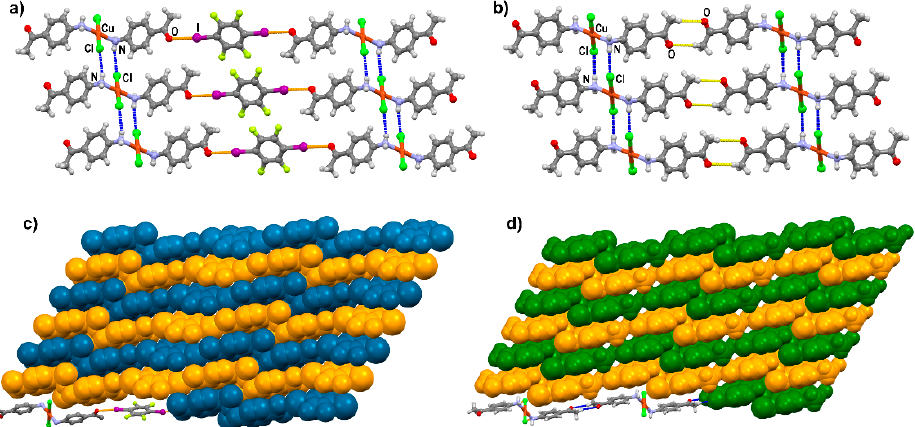
Figure 4. Parts of the crystal structure of ( a ) [CuCl 2 ( aap ) 2 ]( 14tfib ) showcasing the 2D network formed by a combination of halogen (colored orange) and hydrogen bonds (colored blue), ( b ) CuCl 2 ( aap ) 2 with the 2D network resulting from a combination of N–H ··· Cl and C–H ··· O hydrogen bonds (colored blue and yellow, respectively). Layer stacking in ( c ) [CuCl 2 ( aap ) 2 ]( 14tfib ) and ( d ) CuCl 2 ( aap ) 2 . For clarity, adjacent layers are color-coded orange and blue / blue and green.